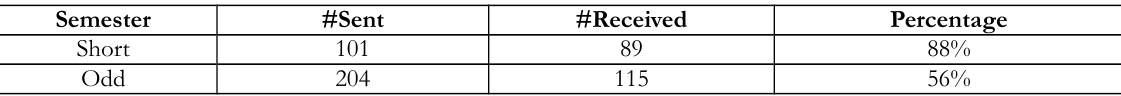
Table 3. The percentage of questionnaires